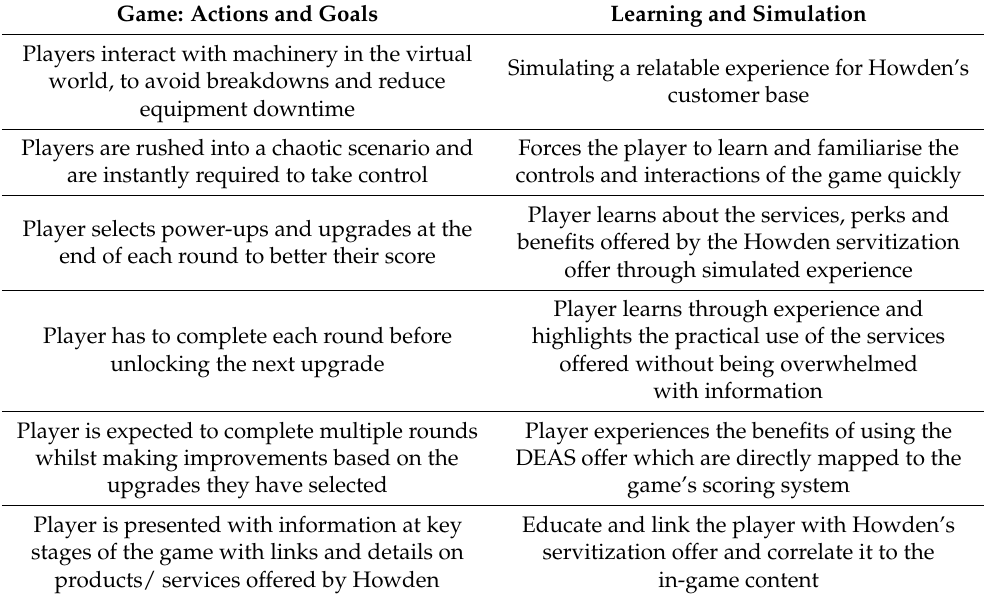
Table 1. Mapping of Actions and Goals with a Learning and Simulation experience. Game: Actions and Goals Learning and